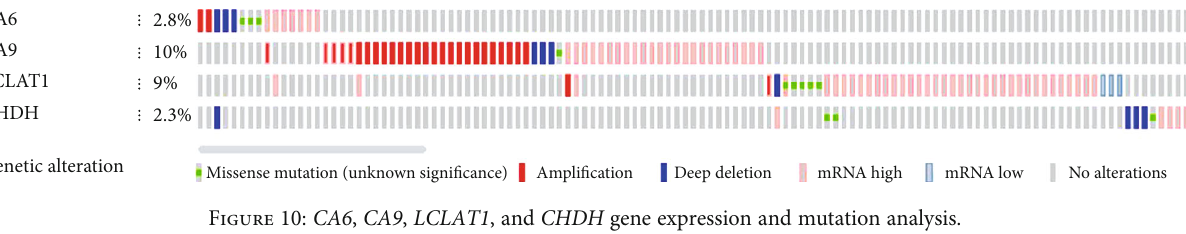
Supplementary Table 1: the expression of included consistent altered metabolic genes in TCGA-HNSCC. (Supplementary